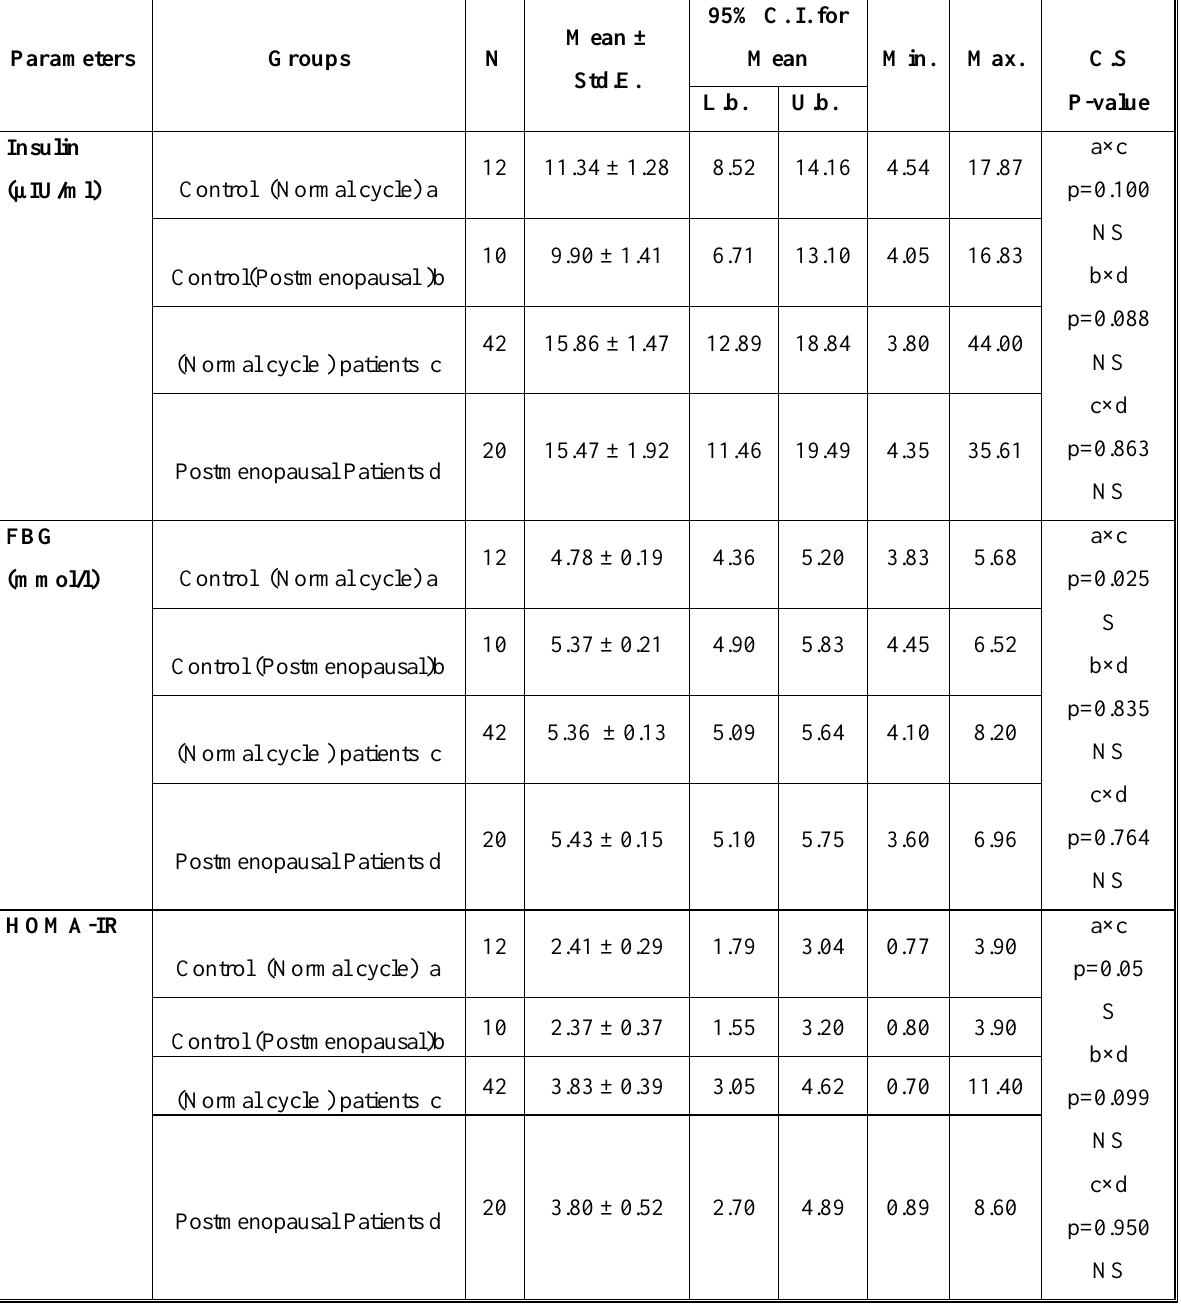
Table 4: Distribution of of insulin, fasting blood glucose and HOMA-IR levels in patients and control